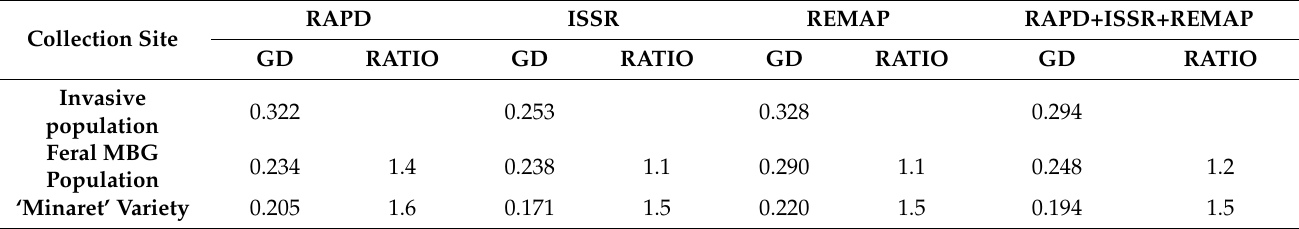
Table 4. The mean values of genetic diversity (GD) for L. polyphyllus invasive and feral populations and the ‘Minaret’ variety obtained by RAPD, ISSR, REMAP and the combination thereof; (RATIO), the ratio of the genetic diversity of the invasive population over the genetic diversity of the given population.